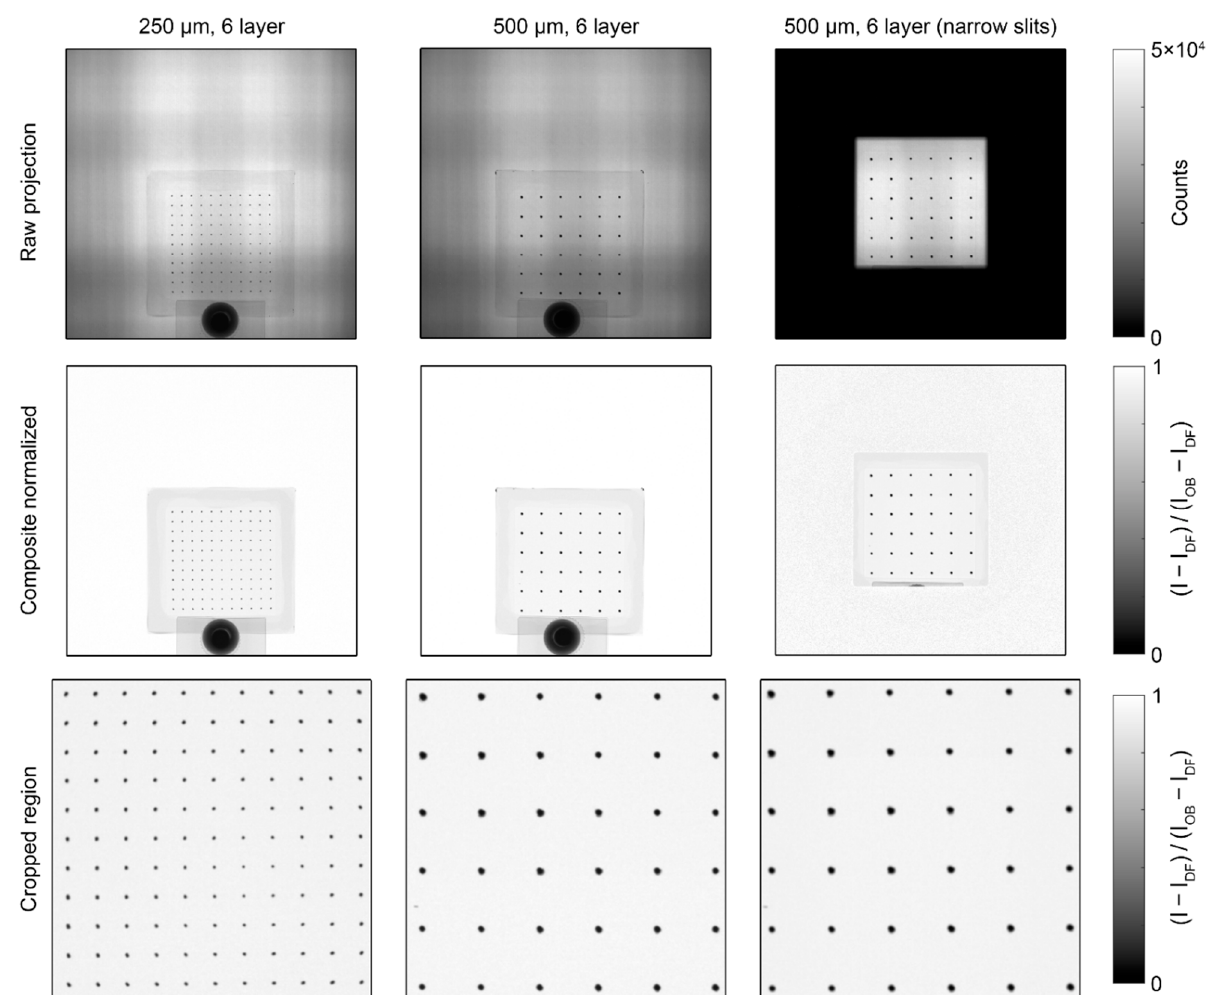
Figure 7. Composite normalized images of the prototype BB grids measured at BT2.